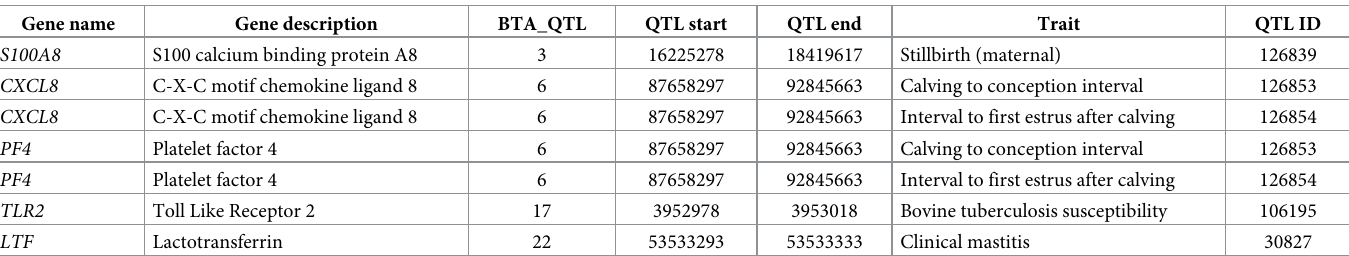
Table 2. Information on bovine Quantitative Trait Loci (QTL) related to reproduction traits overlapping with selected differentially expressed genes (DEGs). Gene